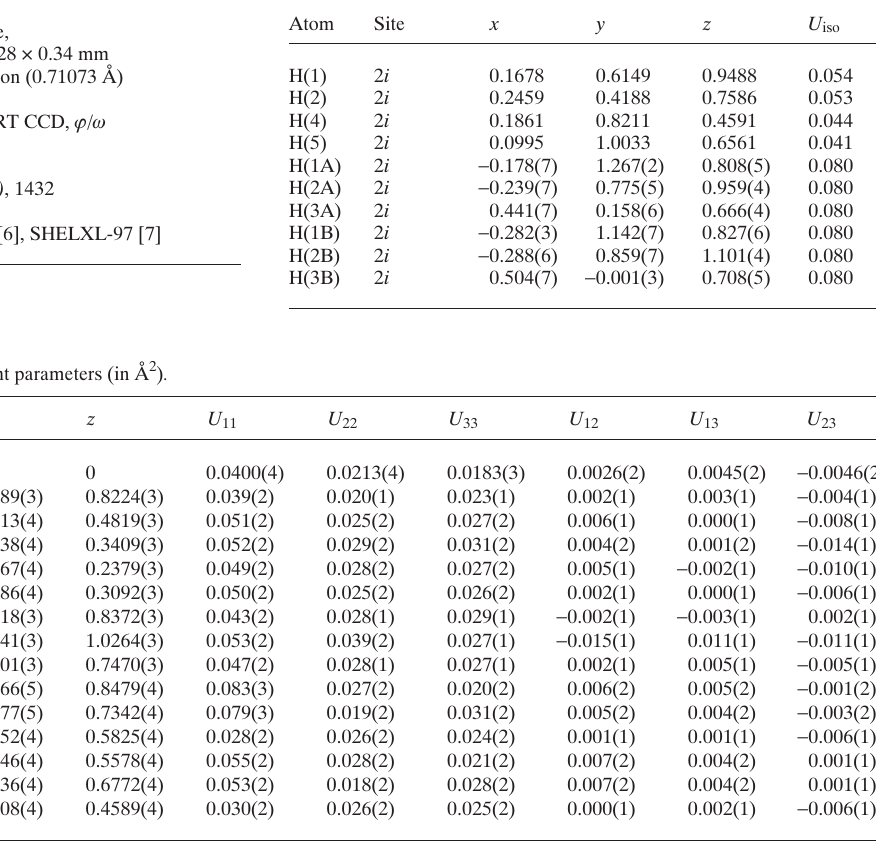
Structures. University of Göttingen, Germany 1997.